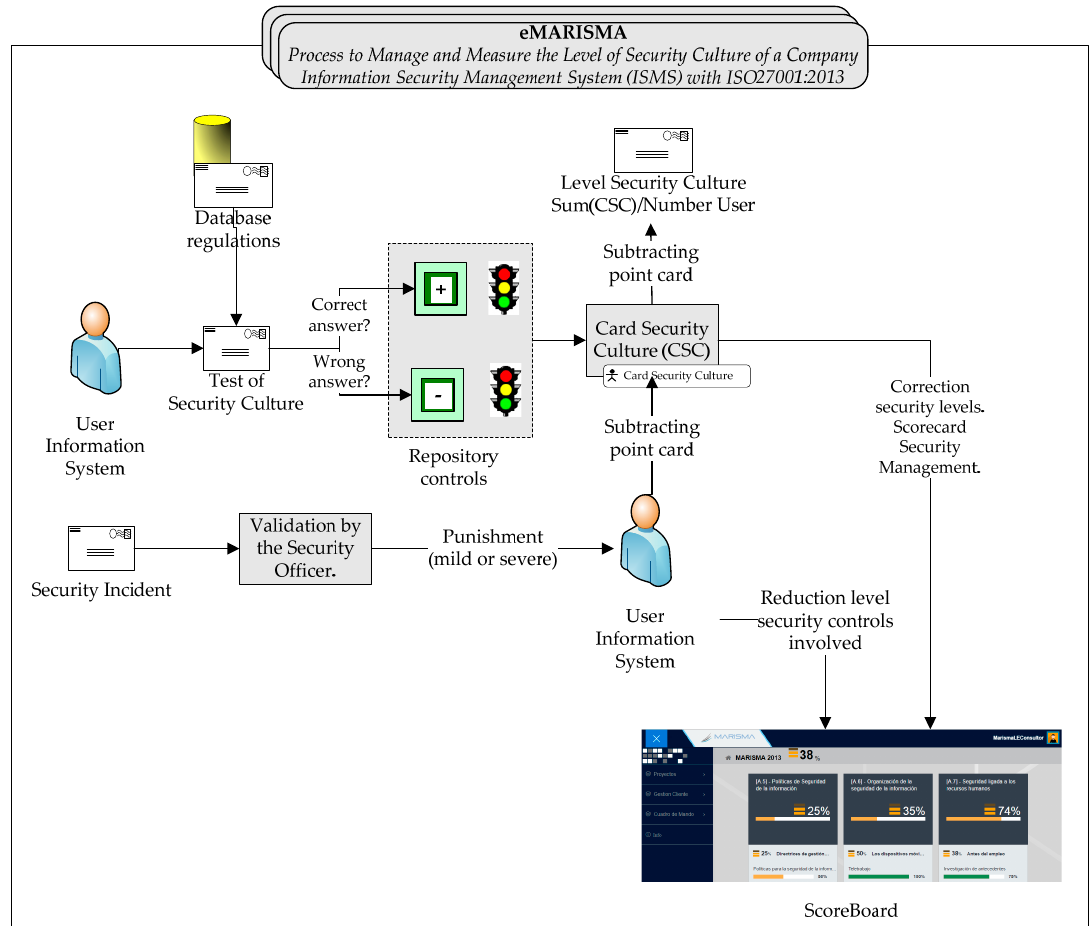
Figure 9. Managing the security culture certificates.